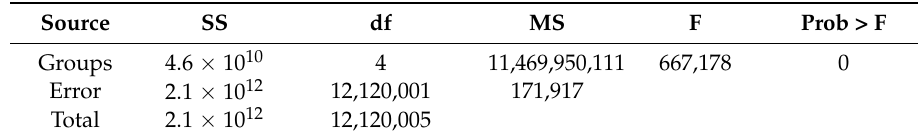
Figure 9. ( A ) Temporal gravimetric water content (GWC) changes for hollows at the Mer Bleue peatland (mean ± standard deviation). ( B ) Probability density function for GWC for the same dates. Table 4. Multiple group comparison for GWC at Mer Bleue for five dates between 4 November 2105 and 23 June